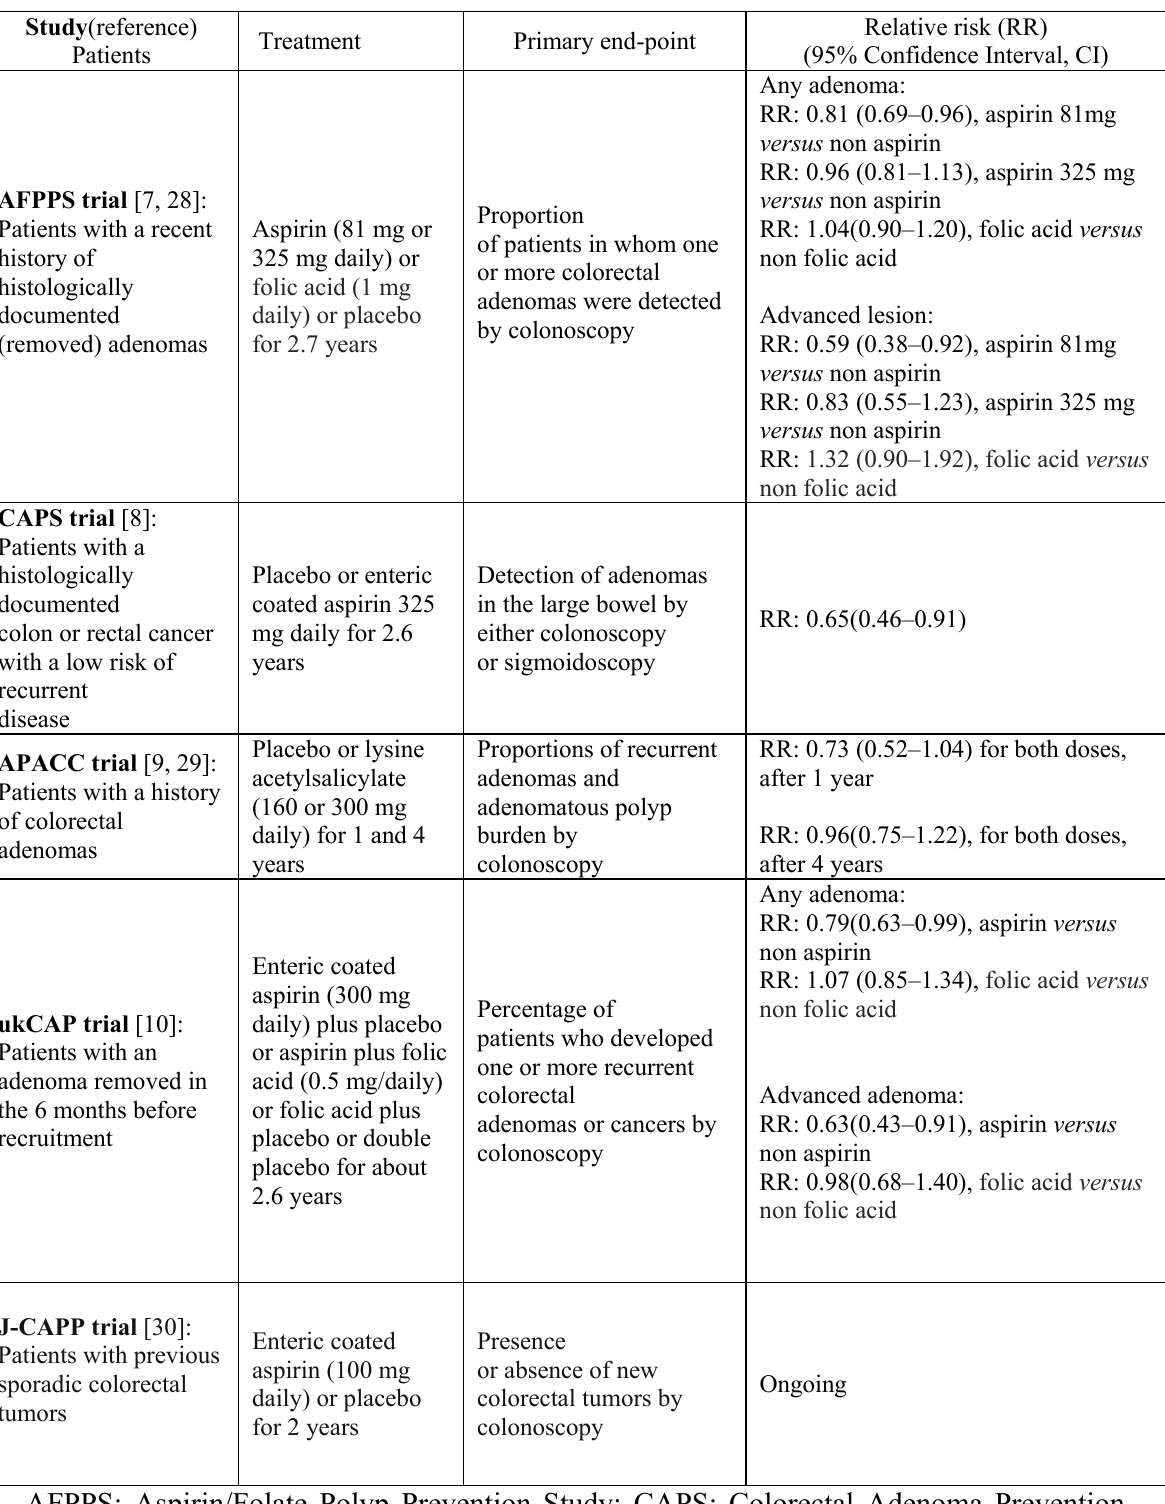
Table 1. Randomized clinical trials of aspirin in the chemoprevention of colorectal